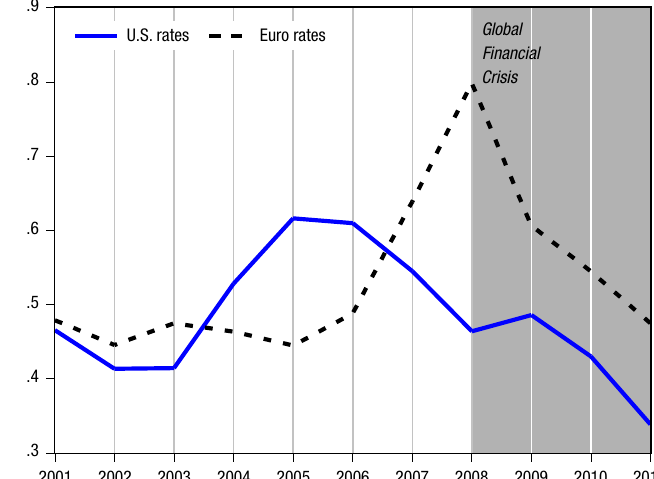
Fig. 1. Dynamics of RER deviation persistence based on 5 years rolling-window against the end year of sample